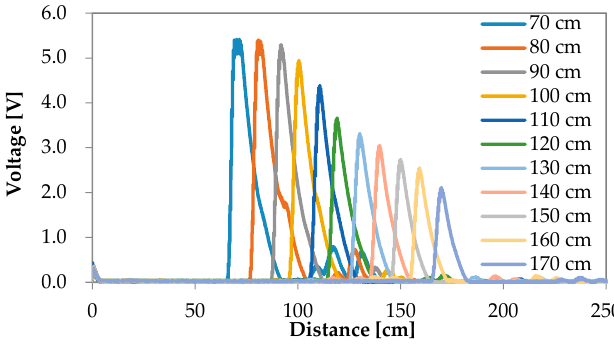
Figure 6. Experimental results of the reflection wave with respect to puddle.